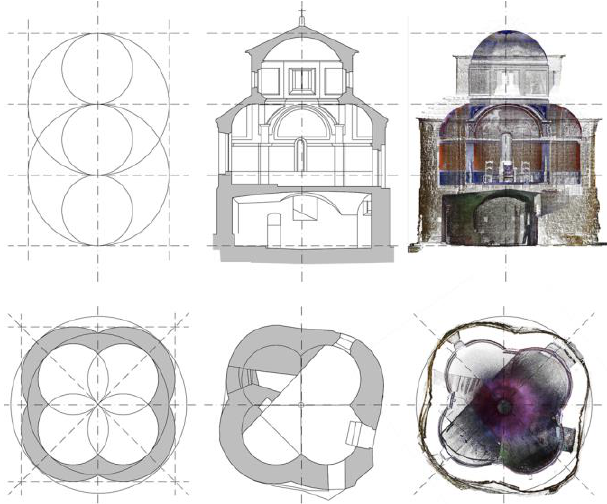
Fig. 2 The church before and after L. Angelini restoration’s works